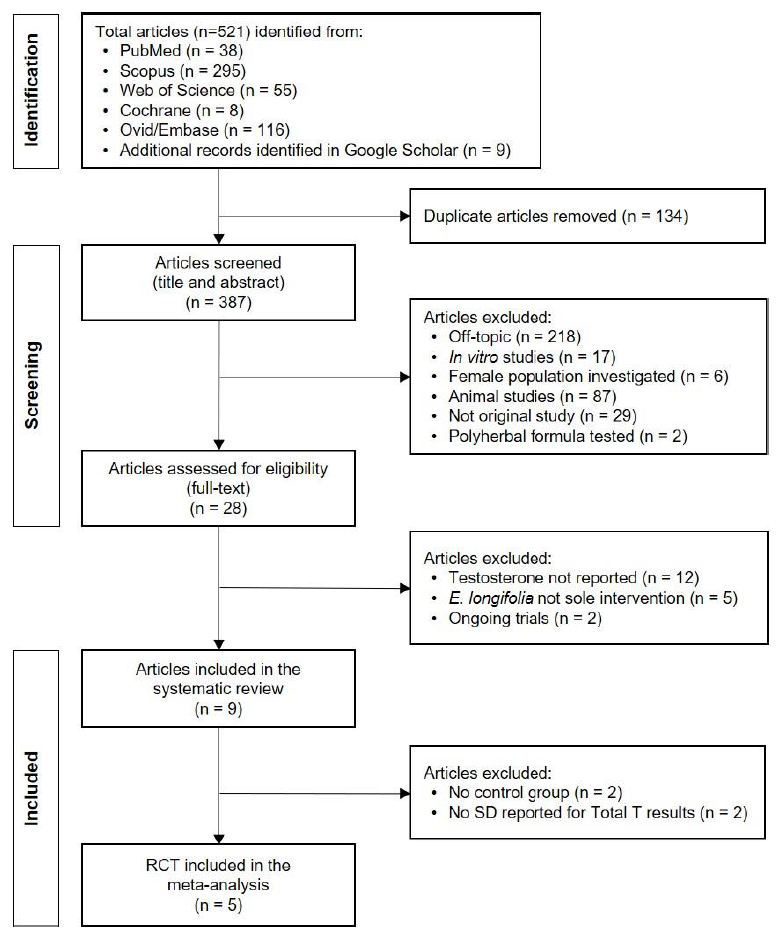
Figure 1. Flow diagram reporting the search strategy. SD: standard deviation.